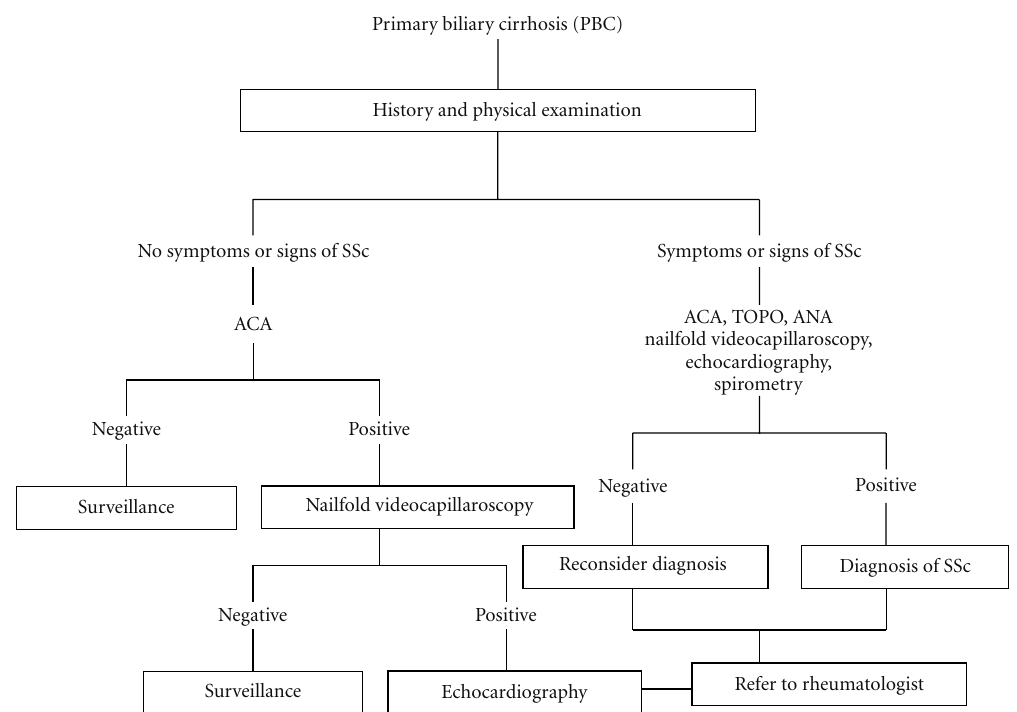
Figure 2: A proposed algorithm for the screening and diagnosis of systemic sclerosis (SSc) in patients with established primary biliary cirrhosis